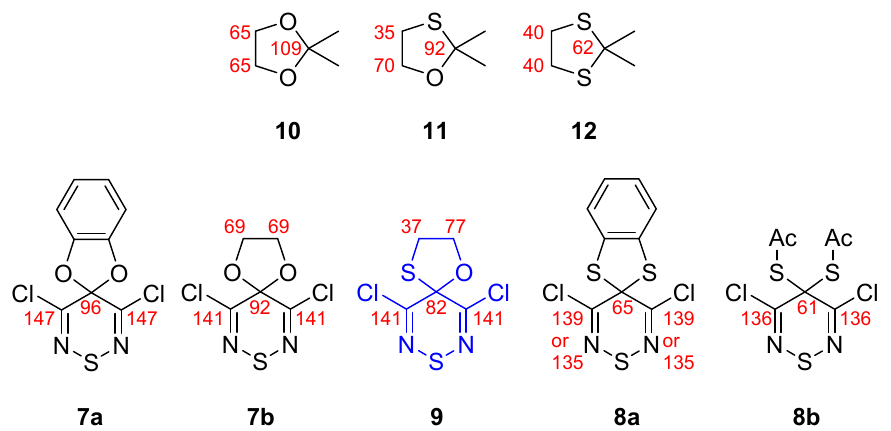
Figure 1. Comparison of 13 C NMR data to literature compounds, numbers in ppm rounded to the closer integer.